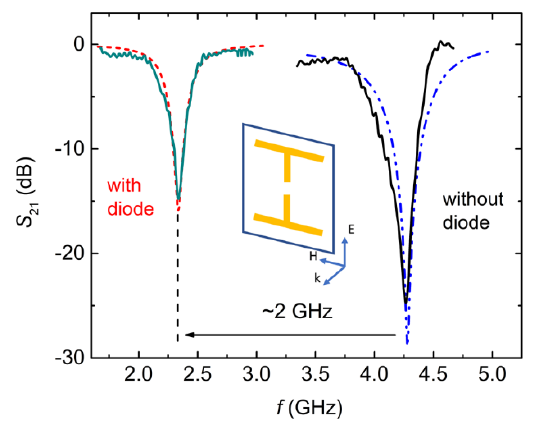
Figure 2. Electromagnetic (EM) response of the FR-4 built metasurface (MS), with diode included into the MS gap (green solid line) and without diode (black solid line). The dashed lines correspond to the results as derived through theoretical simulations. The inset sketch shows the orientation of the MS, with respect to the incident wave.